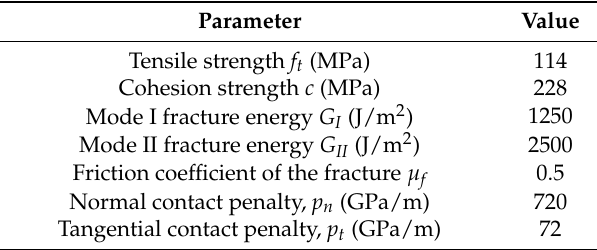
Table 2. Micro properties of the FDEM model.